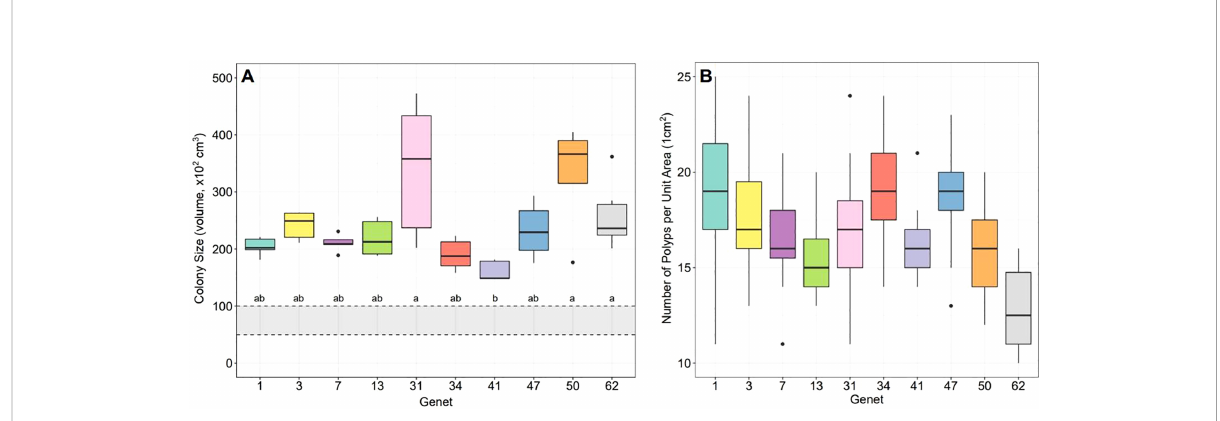
FIGURE 1 Parent colony size and number of polyps per unit area for ten A. cervicornis genets as part of the fragment fecundity analysis. (A) Colony sizes signi fi cantly differed across genets with genet 41 being signi fi cantly smaller than 31, 50, and 62 (statistics in text). Lowercase letters (a, b) indicate the results of the post hoc test where genets with the same letter are not statistically different. The gray shaded region within the black dashed lines represents the estimated puberty size predicted for this species, which is approximately 25-30 cm in diameter, or ~5,000-10,000 cm 3 . (B) The number of polyps within an area of 1cm 2 signi fi cantly differed across genets (statistics in text) with differences attributed to the variation observed in the size and spacing of